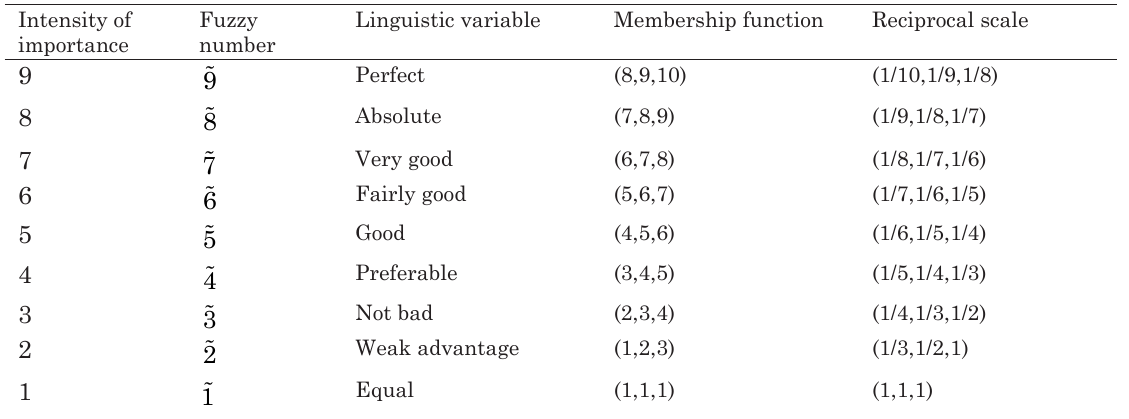
table 1. membership function of linguistic variable Intensity of